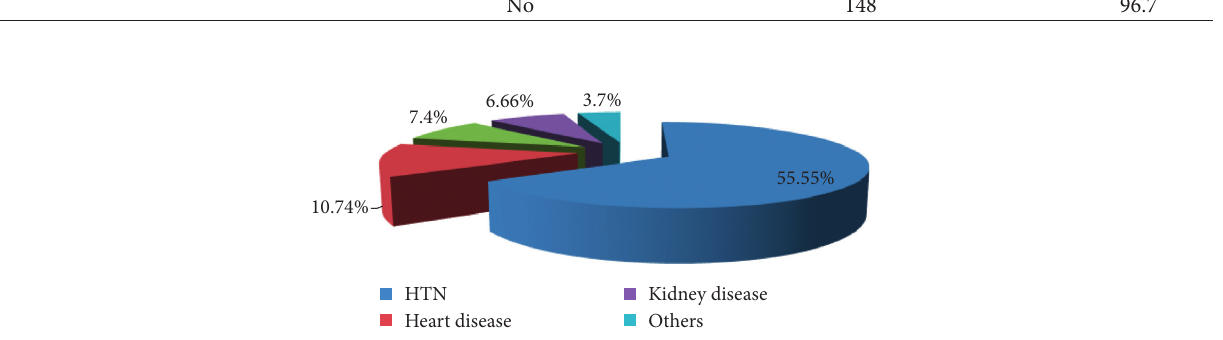
Figure 1: Prevalence of comorbidities among the participants; multiple response was provided by the participants with multiple diseases.